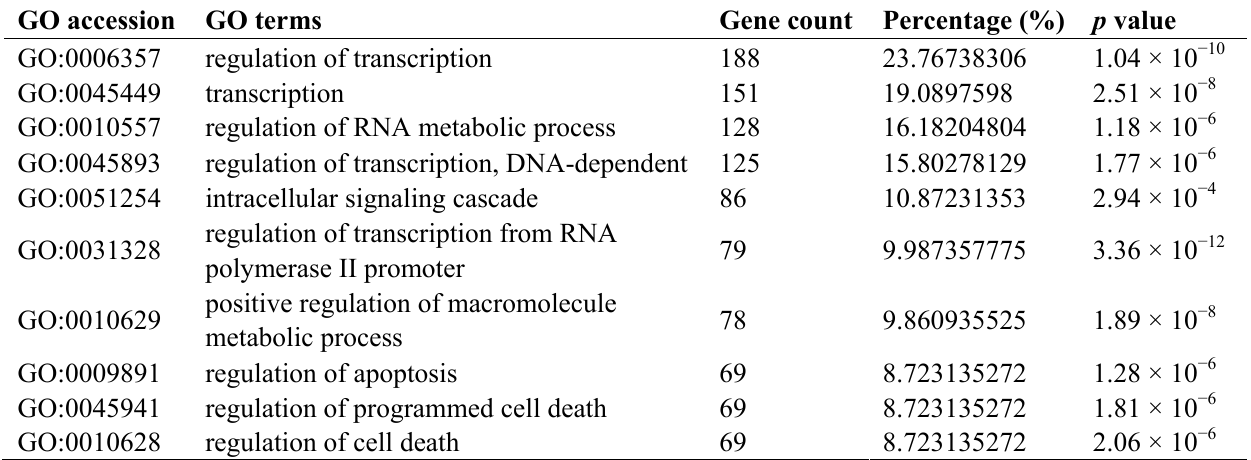
Table 6. The 10 most enriched GO categories in biological process.